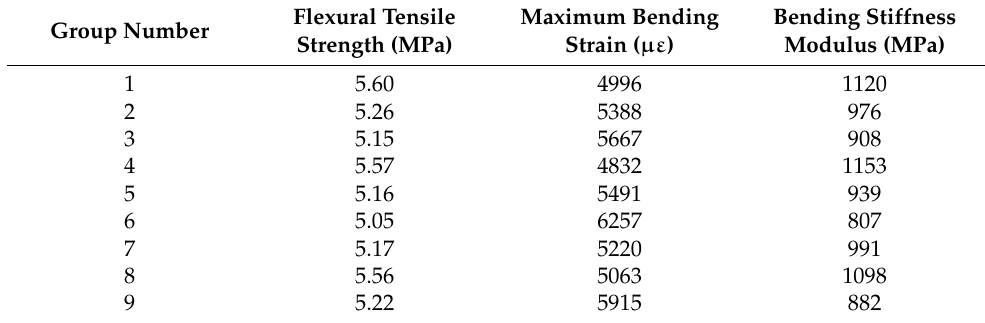
Table 14. Results of low temperature bending test.